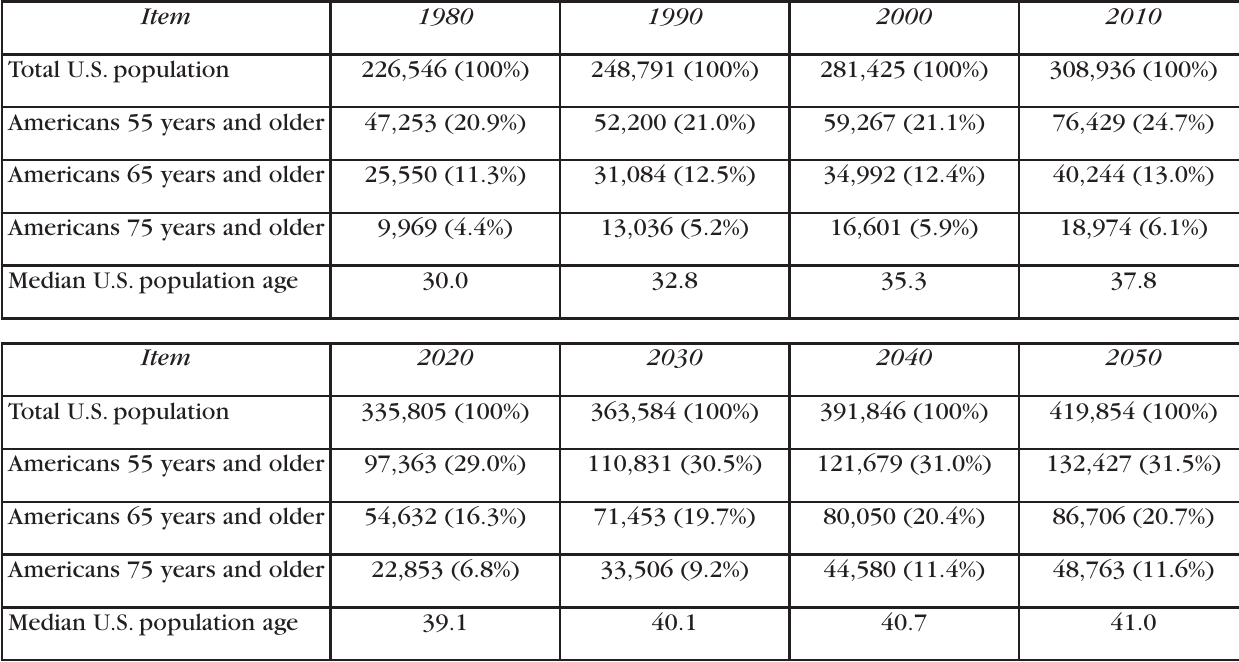
Table 1. Changing U.S. Demographics as a Result of Aging (Based on U.S.Census Bureau Figures and